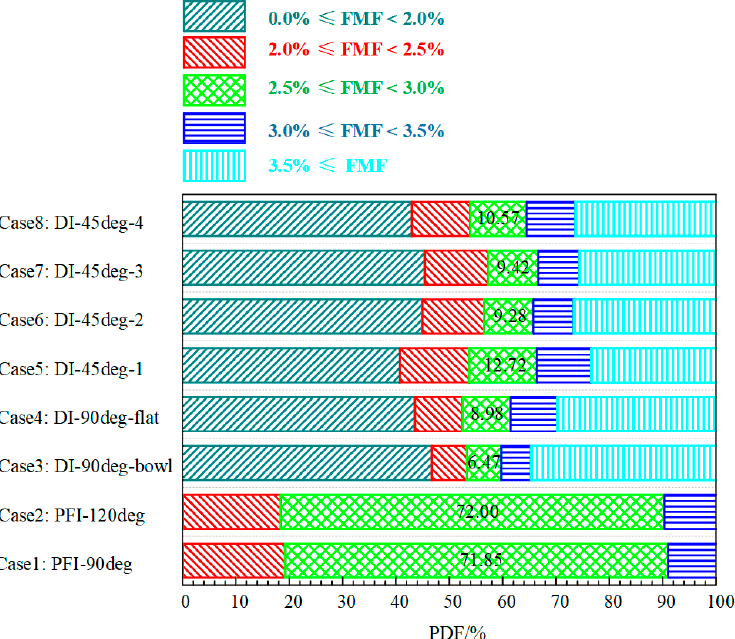
Figure 3. The PDF of all mass fraction regions under different cases at ignition time (340° ATDC).